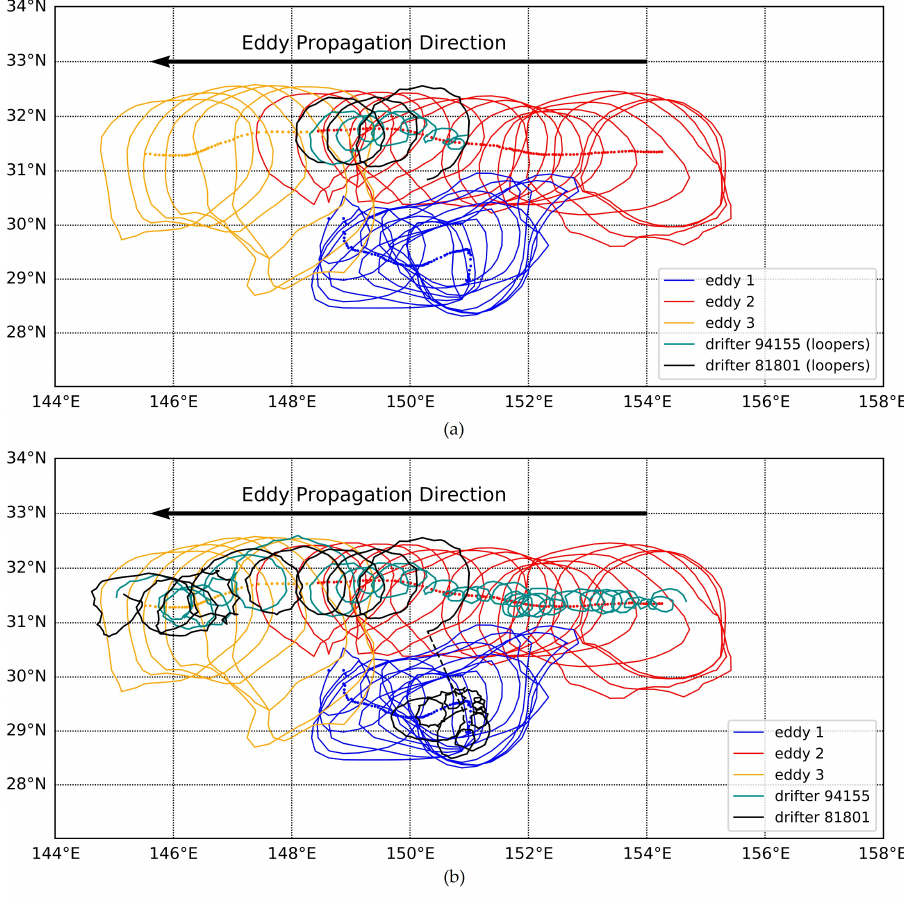
Figure 17. A comparison of the trajectories of a cyclonic eddy merging event detected by our algorithm with the trajectories of loopers in Lagrangian trajectories ( a ) and drifters ( b ). The loopers complete at least two drifter orbits in Lagrangian trajectories. Eddy1 (red solid line) and eddy2 (blue solid line) during 20100530–20100927 approach one another and eventually merge into eddy3 (orange solid line) in the event trajectories detected by our algorithm. The trajectories of drifters in ( a ) are the loopers in Lagrangian trajectories, while the trajectories of drifters in ( b ) are complete trajectories of drifters during this merging event detected by our algorithm EddyGraph . The black dashed line corresponds to the time period (20100728–20100808) in which the signal of drifter 81801 was lost. To express the changes in the shapes of eddies more clearly, the boundaries of each eddy in the middle of its life are shown here in seven-day